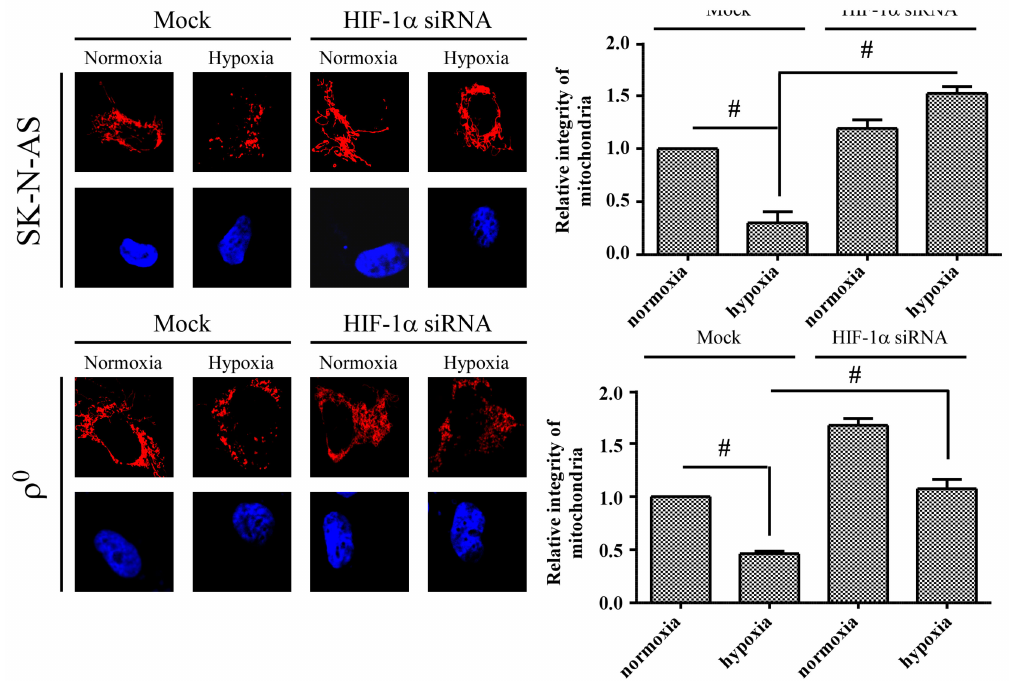
Figure 6. The effect of hypoxia and HIF-1 α on mitochondrial morphology. After transfecting with 20 nM non-targeting siRNA (Mock) or HIF-1 α siRNA (right panel) for 24 h, neuroblastoma cells were further treated with 4 h of hypoxic condition. Morphology of mitochondria in neuroblastoma cells were stained with MitoSOX Red (0.5 µ g) and nuclei were stained with DAPI showing blue fluorescent. Graphs show the relative integrity area of mitochondria by using wand tool function of software ImageJ. Data are shown as mean ± SD of three separate experiments. # Represented p < 0.005 when compared to normoxic Mock condition was determined using the t